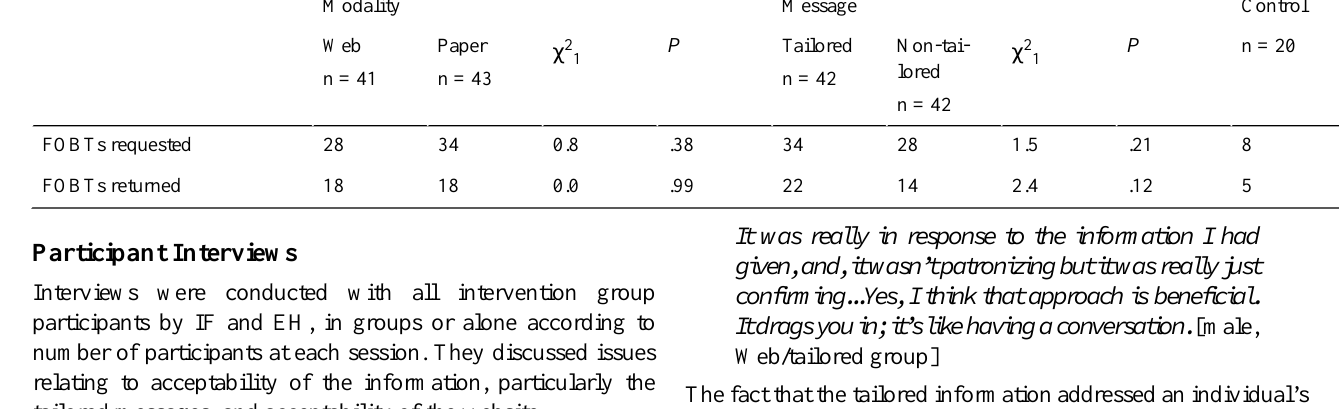
Table 8. Request and return of fecal occult blood tests (FOBTs) by intervention group.